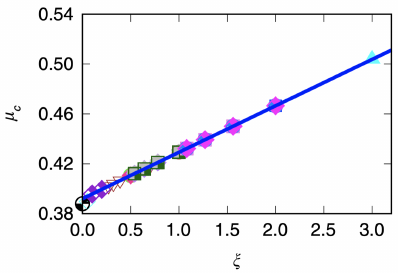
Figure 2. E ↵ ective friction coe  cient in simulated wet materials in quasi-static flow as a function of cohesion number.